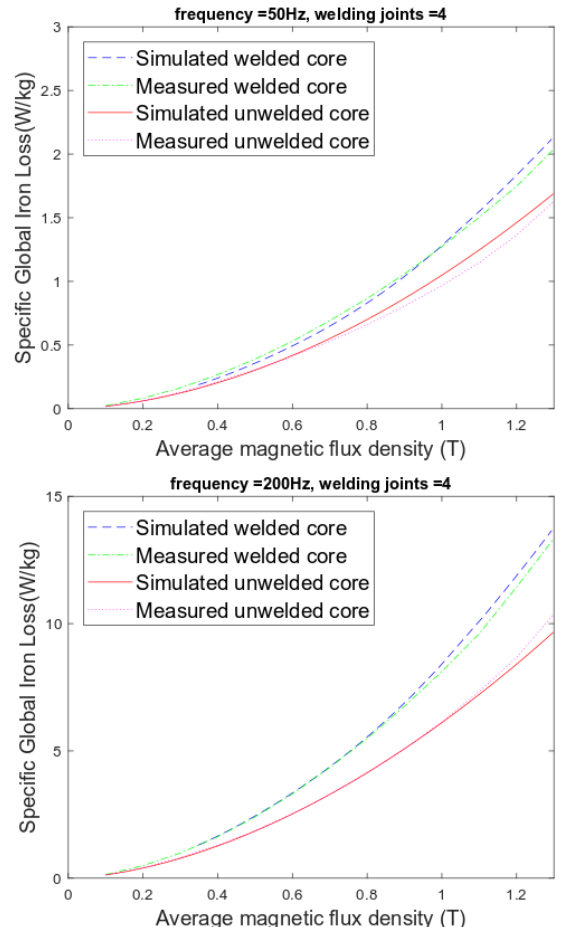
Figure 9. Comparison of the simulated specific losses and measured specific losses as a function of peak flux density for 50 Hz and 200 Hz excitation frequencies. The peak flux density values are averaged over the magnetic cross section, as they are known to vary locally near the welded region. The model parameters were fitted using these data.